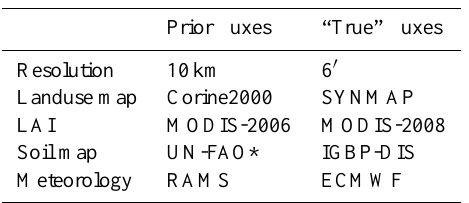
Table 2. Summary of the differences between the FACEM bio- sphere model (“true”) and the 5PM biosphere model (a-priori). In our pseudo-data study these differences mimic the expected struc- tural differences between real CO 2 fluxes and those simulated with a biosphere model, and limit the performance of the inversions sub- stantially.